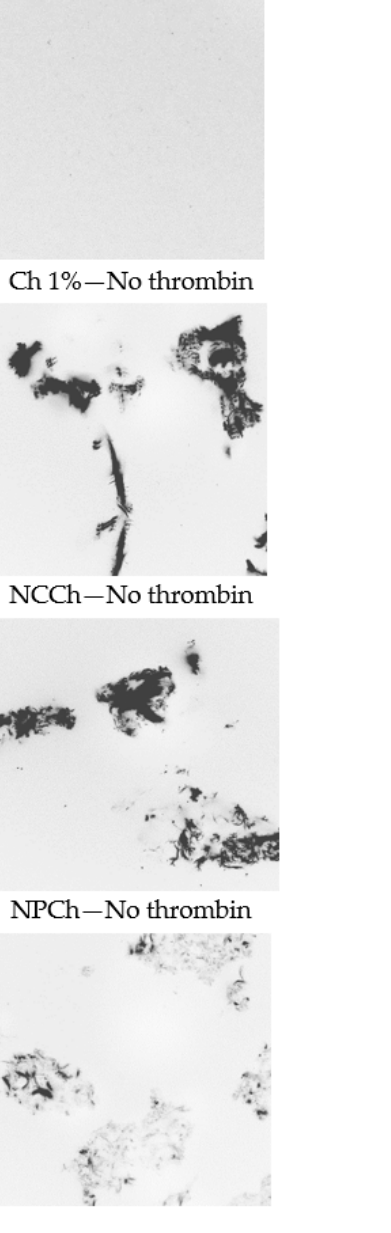
Figure 7. Confocal microscopy for blood clotting analysis for Chitin (Ch), Non-Calcium carbonate crustacean shell (NCCS) and Non-protein crustacean shell (NPCS).